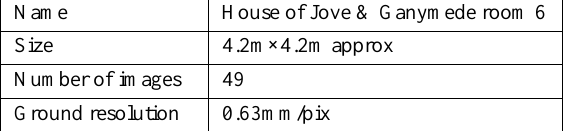
Fig.9 Orthographic and contour images created from SFM & point cloud Table.3 Detail information of SFM: